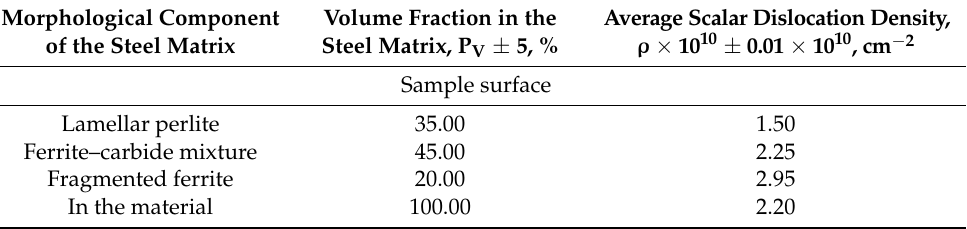
Table 3. Morphological components of 0.34Cr-1Ni-Mo-Fe steel in the initial state and quantitative characteristics of the dislocation structure in